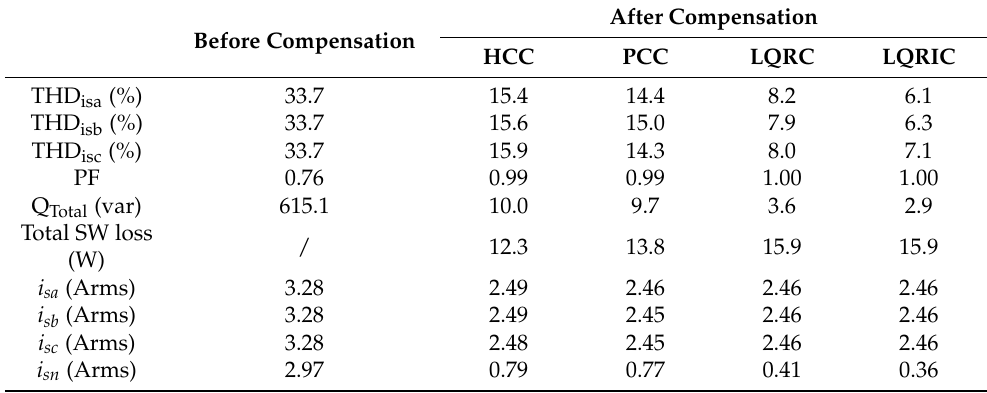
Figure 5. Simulation results of three-phase PCC voltage, source current and neutral current before and after LC -HAPF compensation with ( a ) HCC; ( b ) PCC; ( c ) LQRC; and ( d ) LQRIC under 50V DC-link voltage. (For each graph, the blue lines are the waveforms of source voltage, the red lines are the waveforms of source current, and the peacock blue lines are the waveforms of neutral current.) Table 3. Simulation results before and after the LC -HAPF compensation under 40V DC-link